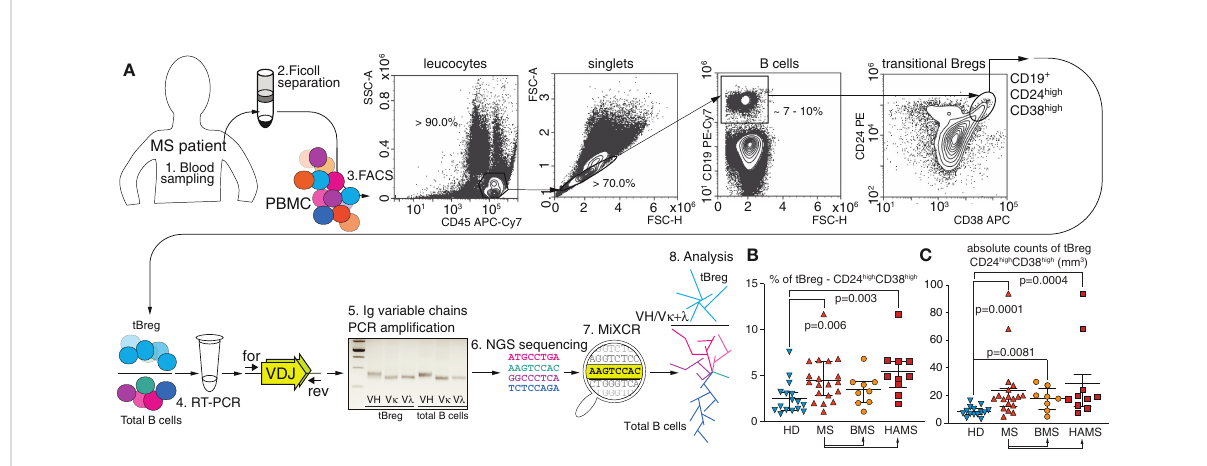
FIGURE 1 MS severity correlates with the elevated level of transitional CD19 + CD24 high CD38 high Bregs in peripheral blood. (A) Total CD19 + B cell pool and transitional regulatory CD19 + CD24 high CD38 high subpopulation (tBregs) from peripheral blood were sorted individually for subsequent RNA isolation and RT-PCR ampli fi cation of IGVH, IGVK and IGVL followed by high-throughput sequencing and subsequent bioinformatic clustering and analysis. (B) The percentage and (C) absolute cell count of transitional Bregs in MS patients (MS) and healthy donors (HD). BMS denotes benign multiple sclerosis, HAMS is highly active multiple sclerosis. Data are shown as mean values, interquartile range, and p -values. The statistical signi fi cance was evaluated with the Mann Whitney test (only signi fi cant p -values are